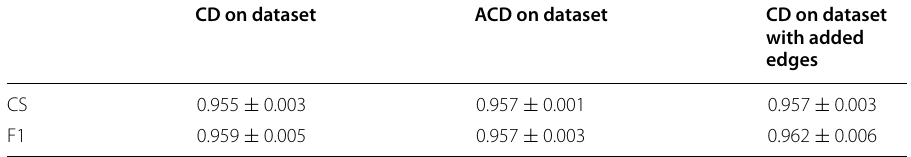
We report CS and F1-score between the inferred communities and those given by metadata. Averages and standard deviations are over 20 runs of the edge addition